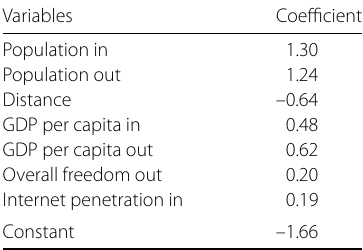
Table 8 Coefficients for the variables of the augmented gravity model with regularization applied to the good trade network. Some coefficients drop to 0 during the variable selection made through the